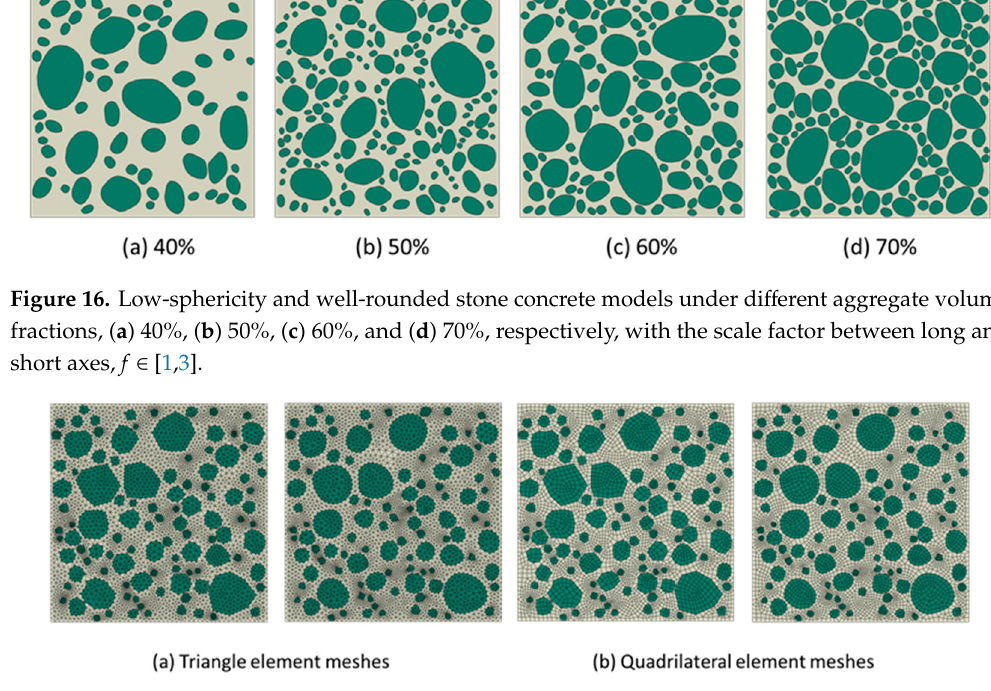
Figure 17. Typical element meshes for the irregular stone and rounded stone concrete models with the aggregate volume fraction 50%. ( a ) Triangle element meshes and ( b ) Quadrilateral element meshes.